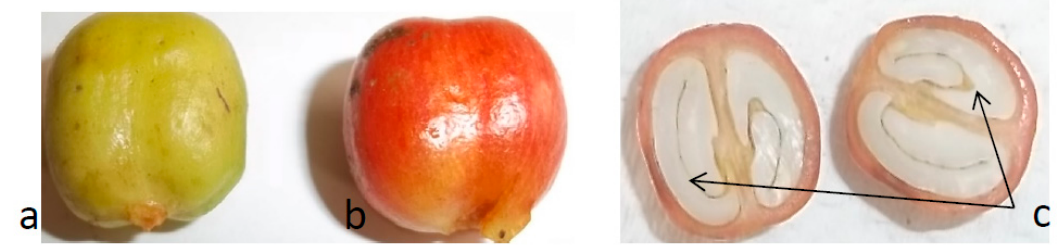
Figure 7. C. canephora coffee beans. Two maturity stages of the beans, ( a ) unripe, and ( b ) ripe are shown. Note, only the ripe beans were used for the analysis. ( c ) The endosperm, which was the portion of the coffee bean dissected and used to extract metabolites for chemical analysis.